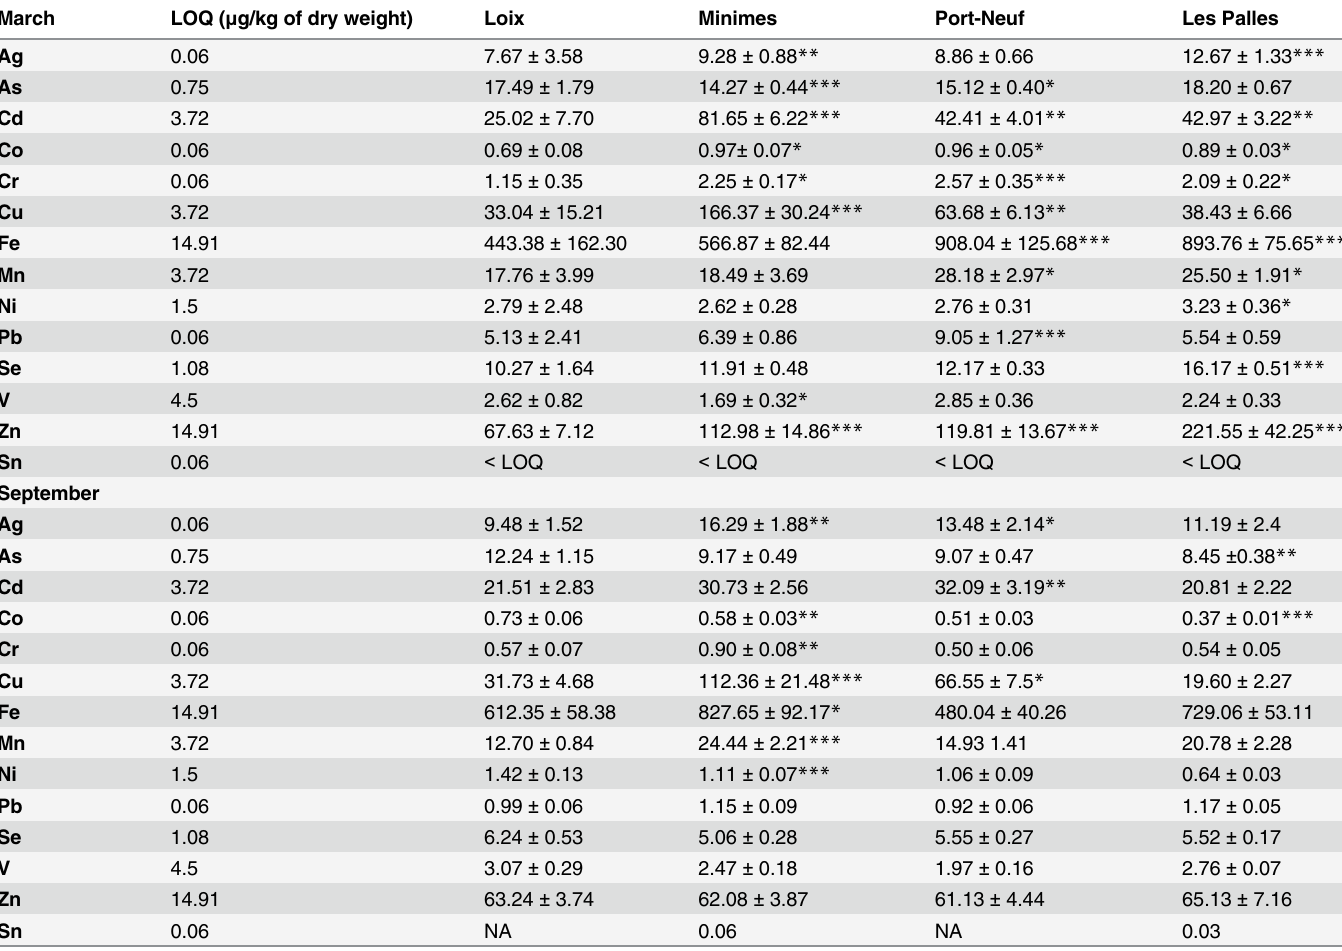
Table 2. Trace element concentrations ( μ g/g of dry weight) in the digestive glands of Mimachlamys varia (7 < n < 10 per sites) from the four sampling areas (Loix-en-Ré, Minimes, Port-Neuf, Les Palles) in March 2014 and in September